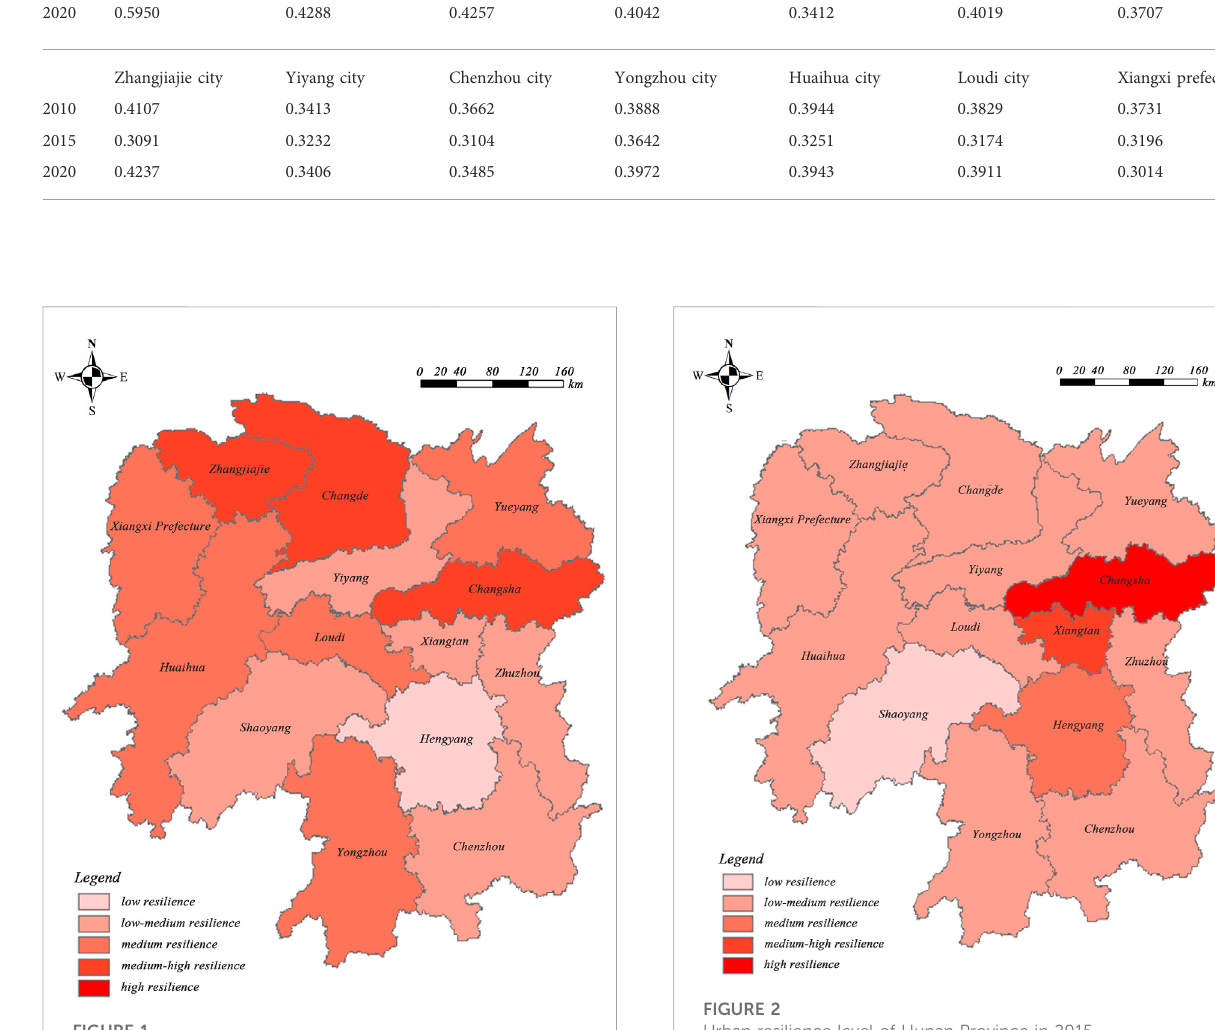
FIGURE 2 Urban resilience level of Hunan Province in